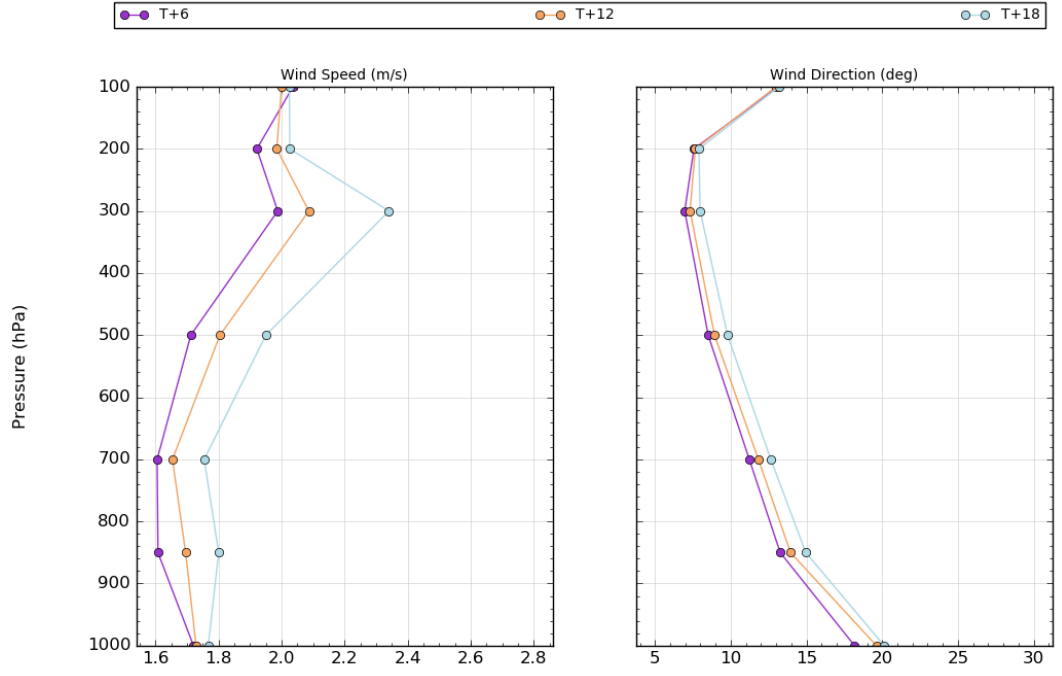
Figure 3. Vertical profiles of Mean Absolute Error, comparing Global model ( Left ) forecast wind speed and ( Right ) forecast wind direction to radiosonde data during